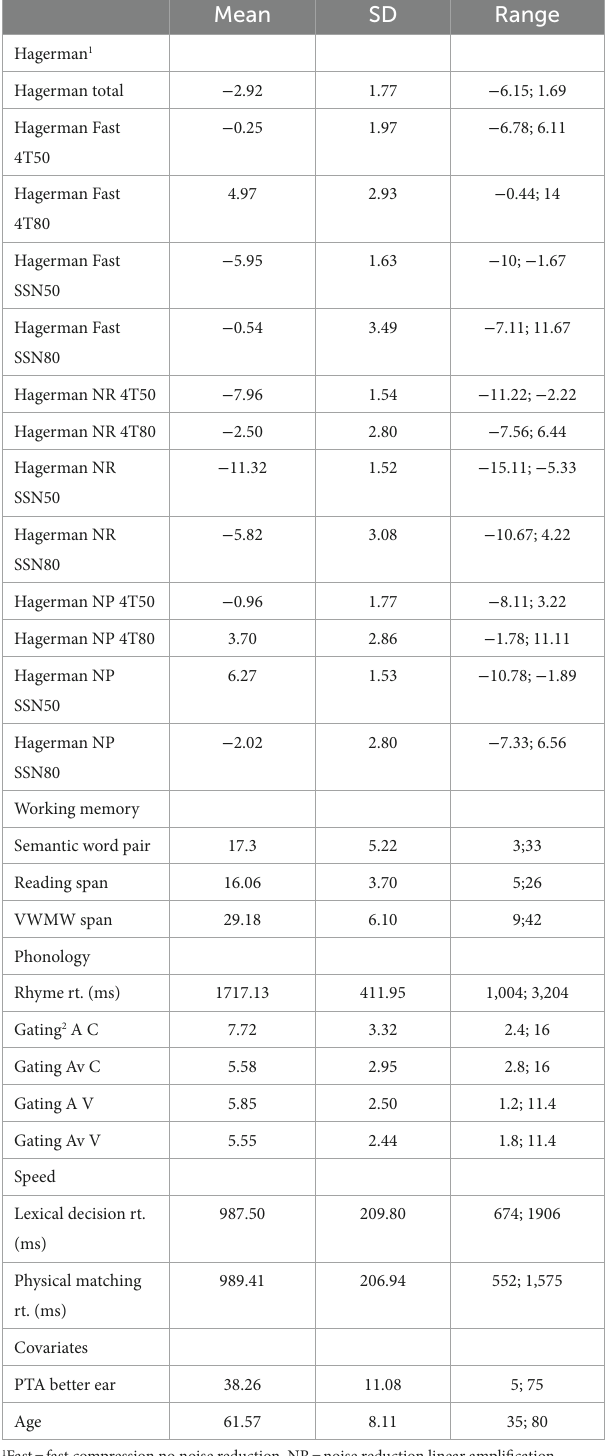
TABLE 2 Descriptive statistics of measures used in the analysis ( n =